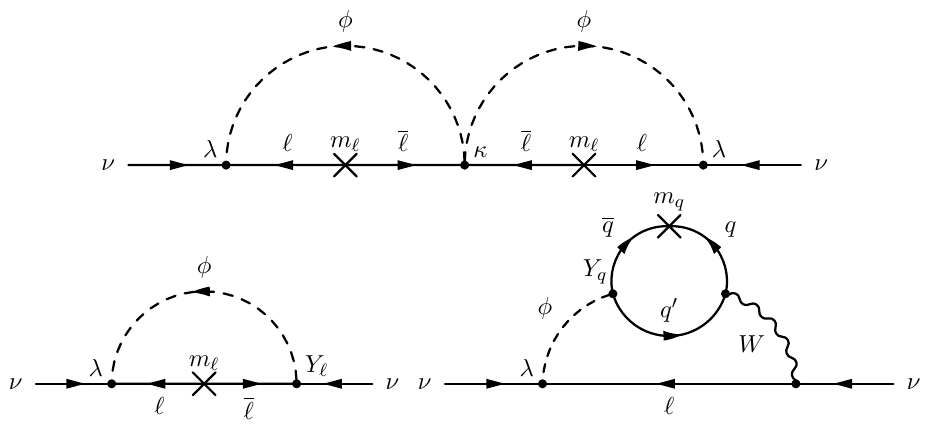
Figure 1 . One- and two-loop contributions to neutrino